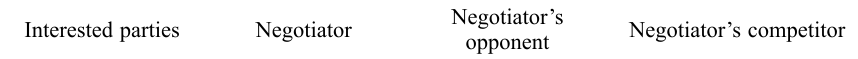
Table 1. International business negotiation strategy and the preparation of the theoretical model based on bargaining power